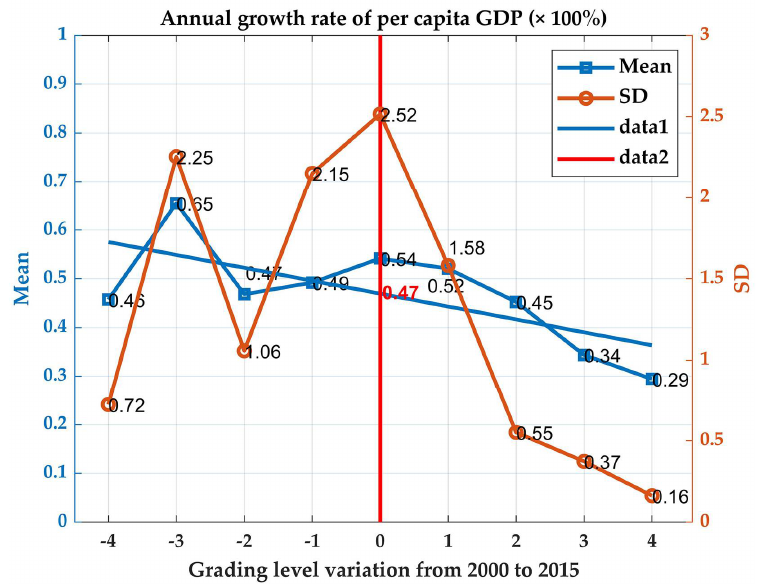
Figure 7. Relationship between the annual growth rate of per capita GDP ( × 100%) and the variation in eco–environmental vulnerability from 2000 to 2015.